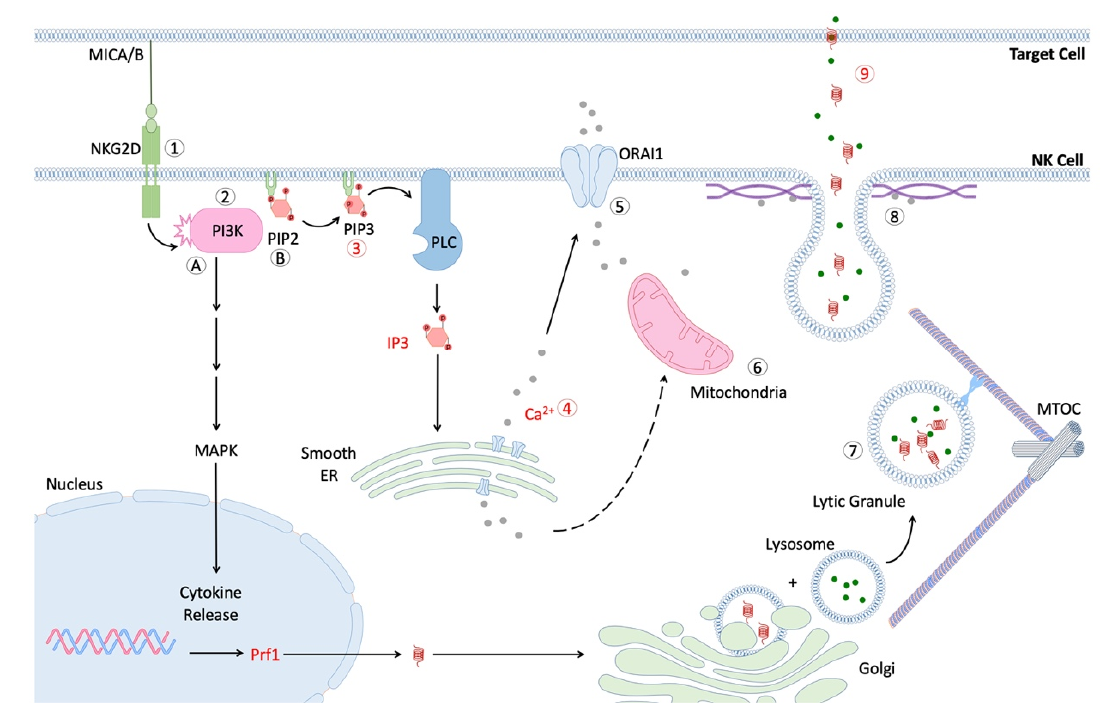
Figure 1. Scheme of NK cell signaling after formation of immunological synapse (IS). Interaction of activating receptor with cognate ligand leads to phosphorylation of cytoplasmic tail and recruitment of PI3K [61,120] . Pathway ( A ) activation of PI3K and PLC lead to downstream signaling via MAPK and NFκB pathways, respectively, thus facilitating the production and secretion of cytokines, such as IFN-γ. Activation of MAPK signaling also contributes to MTOC migration and the polarization of lytic granules. Pathway ( B ). Conversion of phosphatidylinositol-4, 5-bisphosphate (PIP2) to phosphatidylinositol-3, 4, 5-triphosphate (PIP3) allows for subsequent generation of the secondary messenger inositol trisphosphate (IP3) via phospholipase C (PLC) [117]. IP3 contributes to the release of internal calcium stores from the smooth endoplasmic reticulum [123], which in turn facilitates mitochondrial migration to IS and influx of extracellular calcium via the ORAI1 trans- porter [118,119]. Additionally, the microtubule organization center (MTOC) migrates towards the IS and allows for efficient transport of lytic granules (secretory lysosomes) to travel to the IS [124,125]. Lastly, lytic granules fuse with the NK cell membrane in a calcium-dependent manner and release perforin and granzymes into the IS [126]. These proteins form holes in the target cell membrane and induce